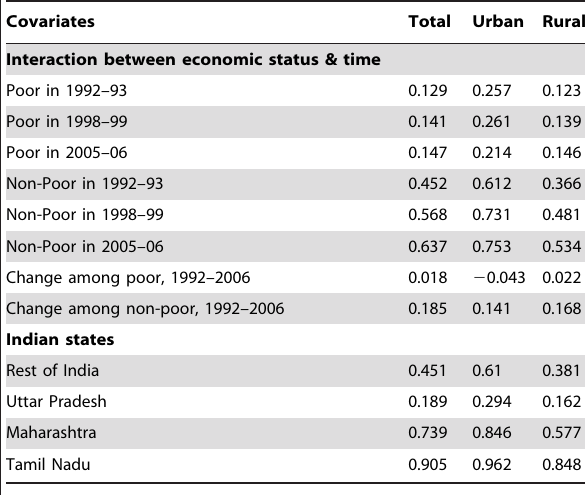
Table 7. Predicted probabilities of skilled birth attendance adjusted for socioeconomic & demographic characteristics, India, 1992–2006 {